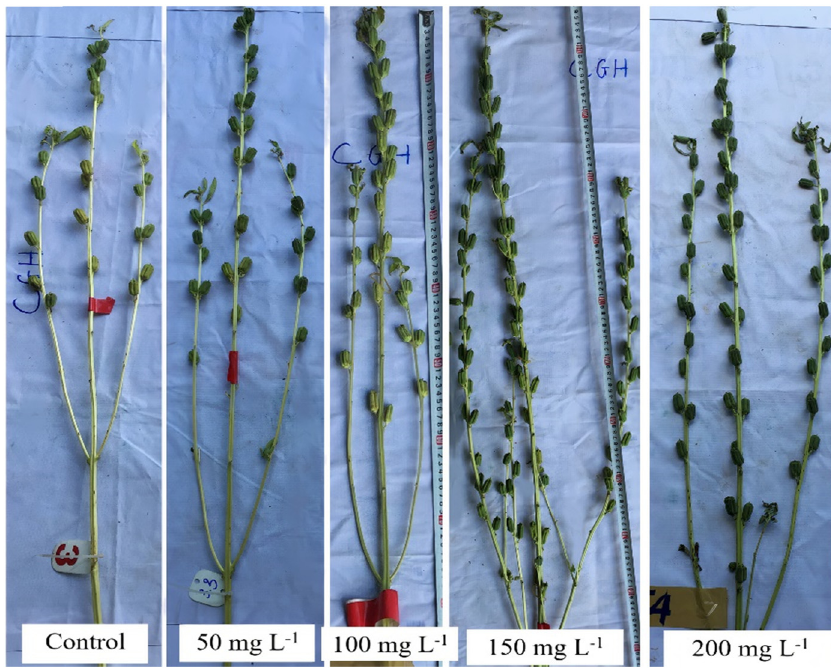
Figure 6: Number of fruits on sesame plants at di ff erent concentrations of boron.